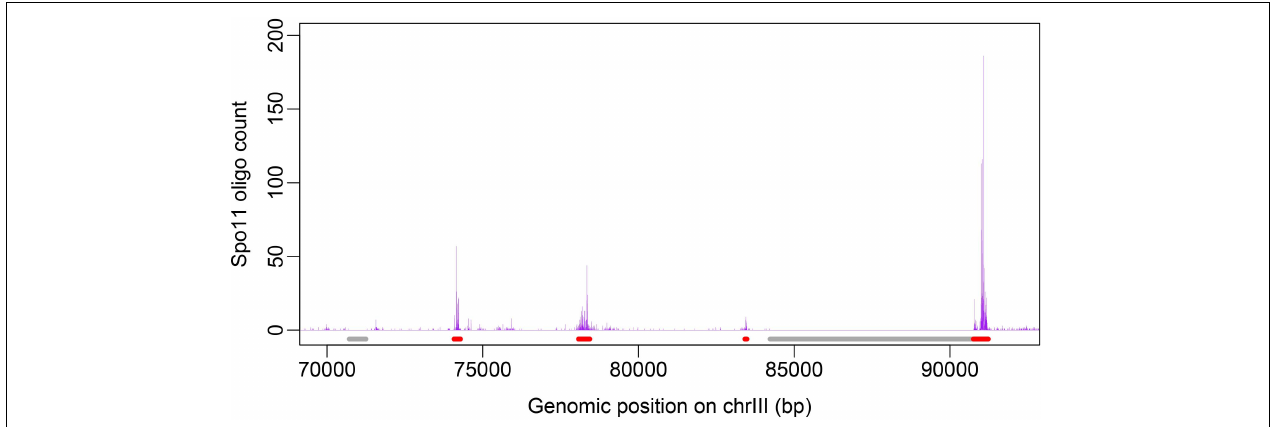
FIGURE 1 | Distribution of hot/cold spots along chromosome is shown with Spo11-oligo signal taken from Pan et al. (2011). Genomic regions marked in red denote hotspots and gray represent coldspots defined in this study.